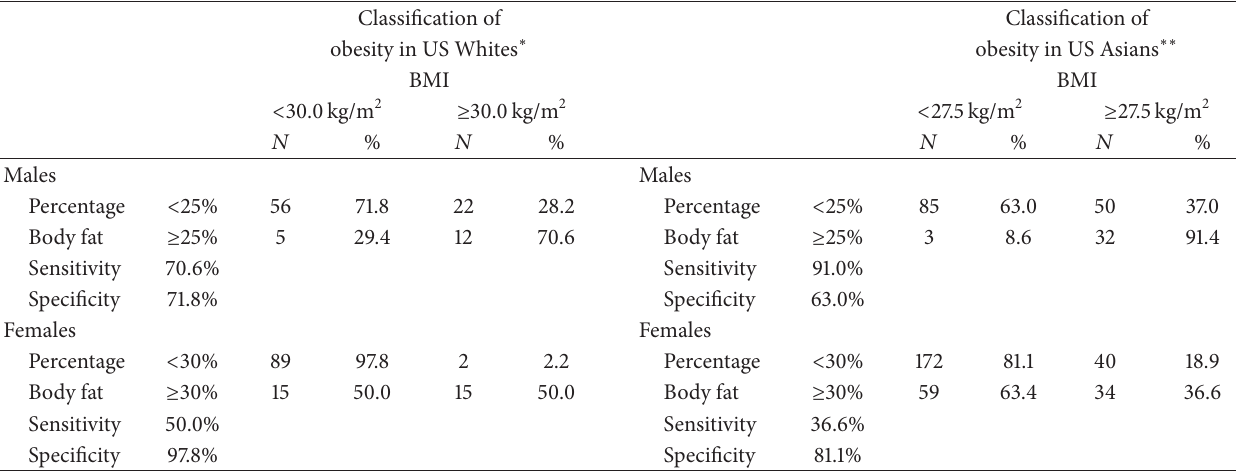
Table 3: Classification of obesity for Asian-American and US white college age adults using body-mass index and percentage body